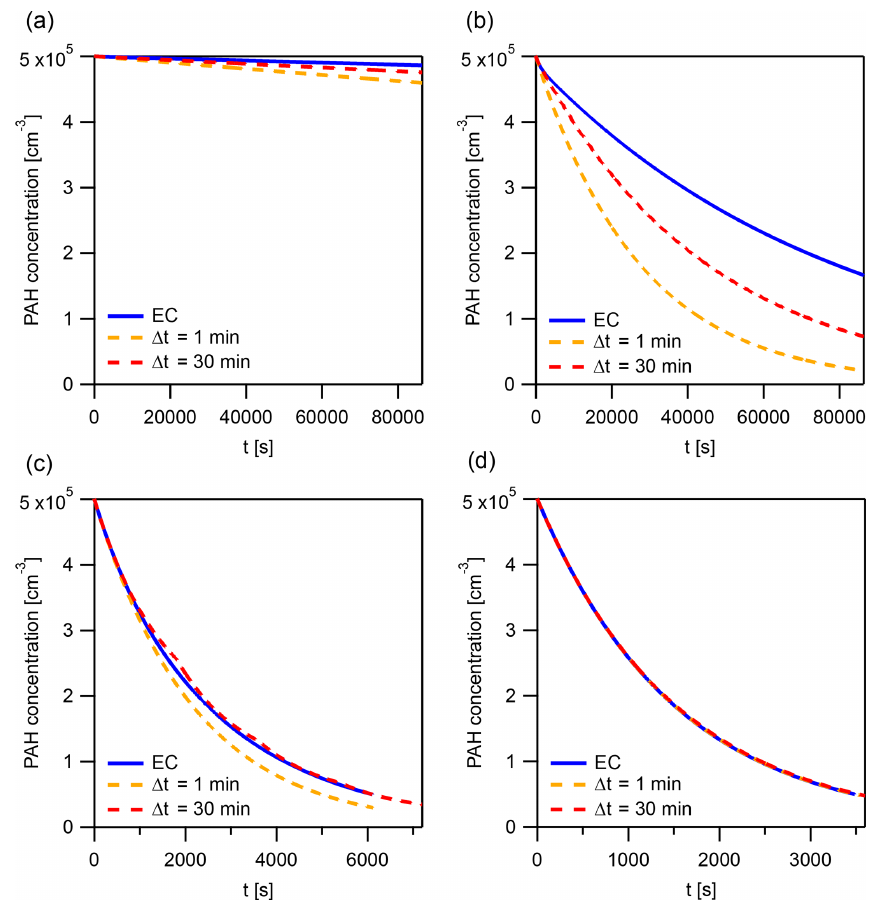
Figure A6. The explicitly coupled (EC) solution and instantaneous-equilibration (IE) solutions with time steps (cid:49)t = 1 and 30min at specific points for the evaluation of the error metric E loss (Fig. A4b). These points represent a horizontal cross section of Fig. A4b at [ OH ] = 1 × 10 7 cm − 3 and the following k des : (a) 10 − 6 . 3 , (b) 10 − 4 . 7 , (c) 10 − 3 . 1 , and (d) 10 − 1 . 5 s − 1